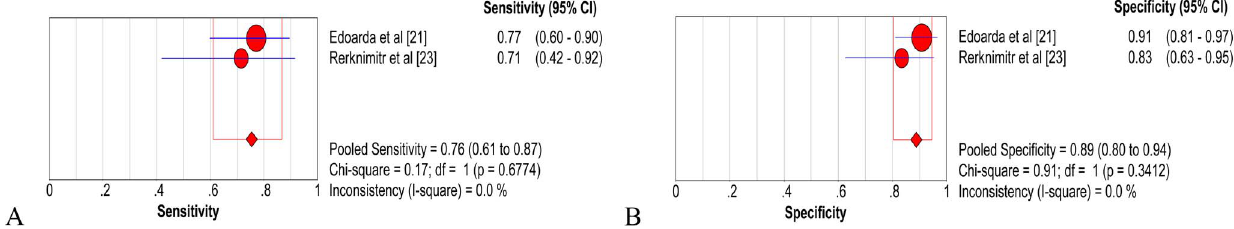
Figure 3. Gastric intestinal metaplasia (GIM), per-patient analysis of diagnostic performance of magnification narrow band imaging (NBI-ME). A. Pooled sensitivity for NBI-ME to differentiate GIM; B. Pooled specificity for NBI-ME to differentiate GIM; C. The summary receiver operating characteristic (SROC) cure for diagnosis by NBI-ME. CI, confidence interval; df, degrees of freedom; AUC, area under curve; SE, standard